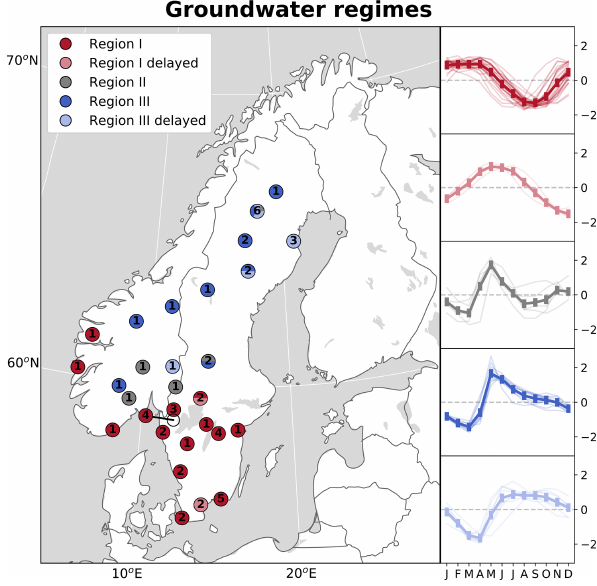
Figure 2. Locations and groundwater regimes (based on Kirkhusmo, 1988) of the 56 groundwater wells used in the study. The number on each point represents the number of stations at that location. To ease readability, one site with four wells in southwest- ern Sweden (red point on the map) is shifted to the left of (and pointing to) its real location. The right panels show plots of mean monthly standardised (i.e. subtracted the mean and divided by the standard deviation) groundwater levels for each regime (indicated by thin lines) together with the regime mean groundwater levels (bold